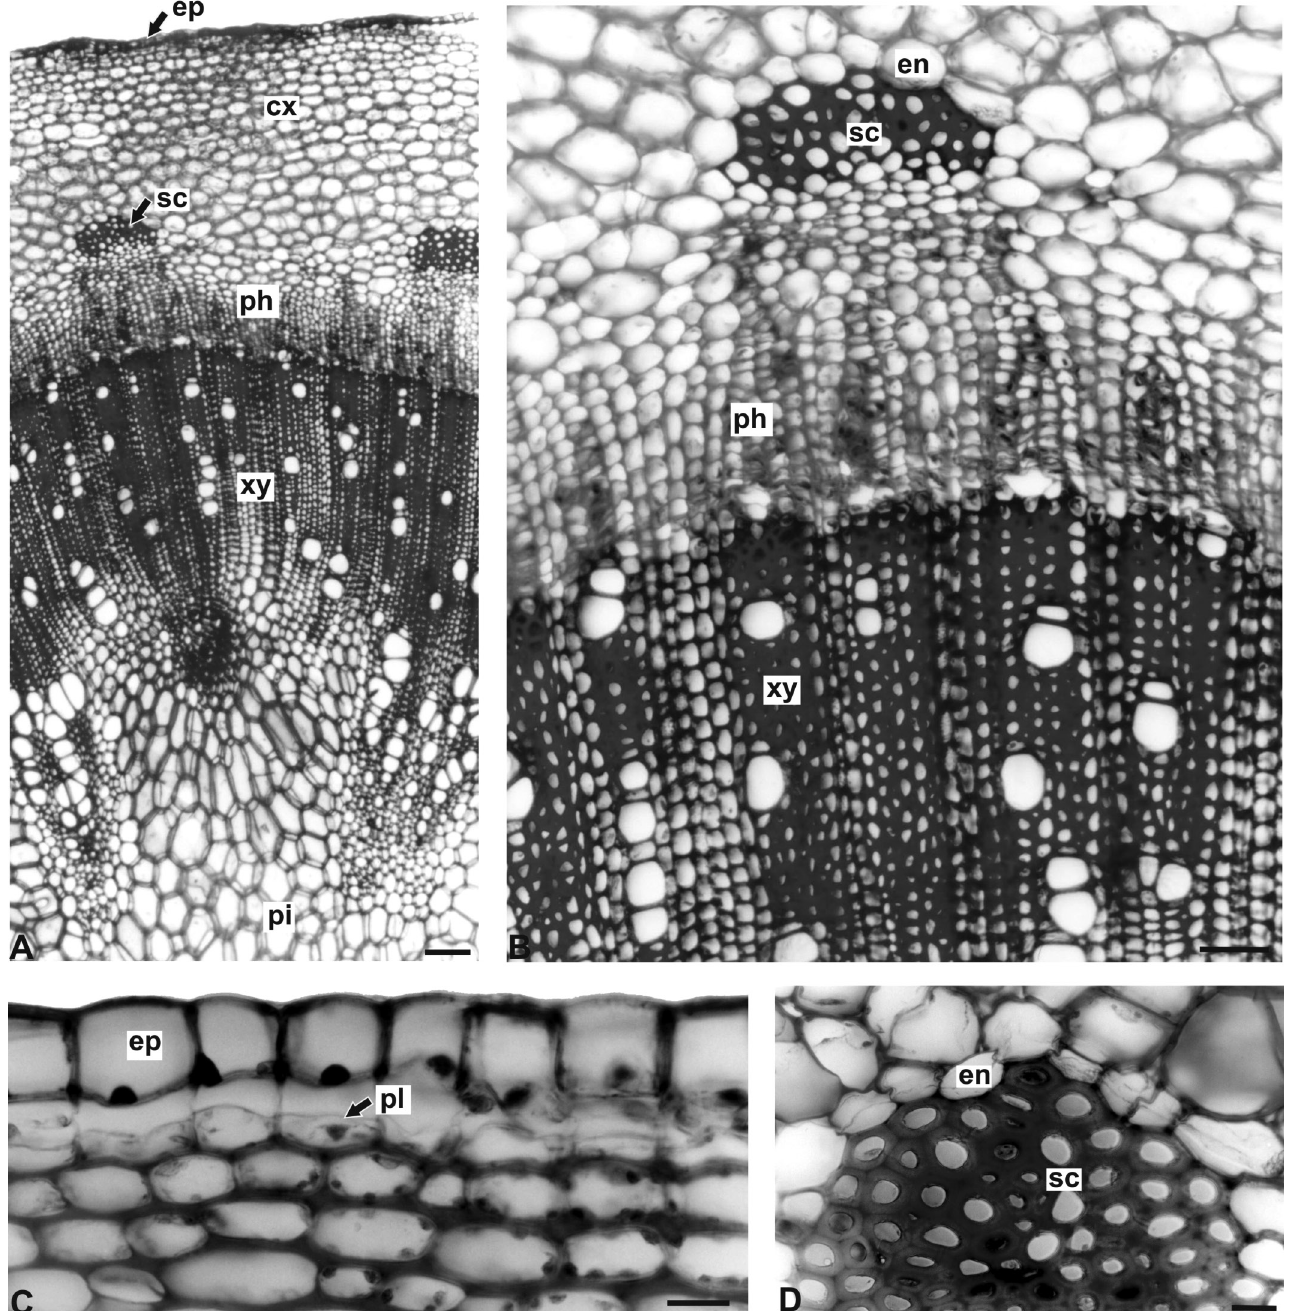
FIGURE 4 - A-D: Gymnanthemum amygdalinum (Delile) Sch.Bip. ex Walp. – stem, transverse section: A. Overall organization; B. Detail of the vascular cylinder; C. Phellogen development; D. Detail of the endodermis and a sclerenchymatic cap. Abbreviations: cx – cortex, en – endodermis, ep – epidermis, ph – phloem, pi – pith, pl – phellogen, sc – sclerenchymatic cap, xy - xylem. Bar = 100 µm (A), 50 µm (B), 20 µm (C,